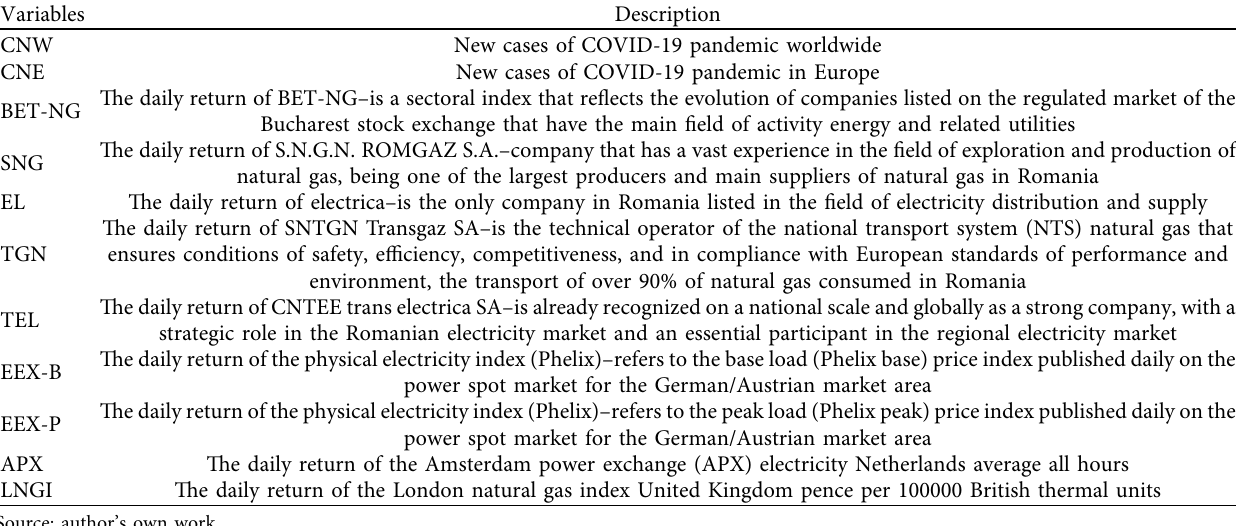
Table 2: Variables’